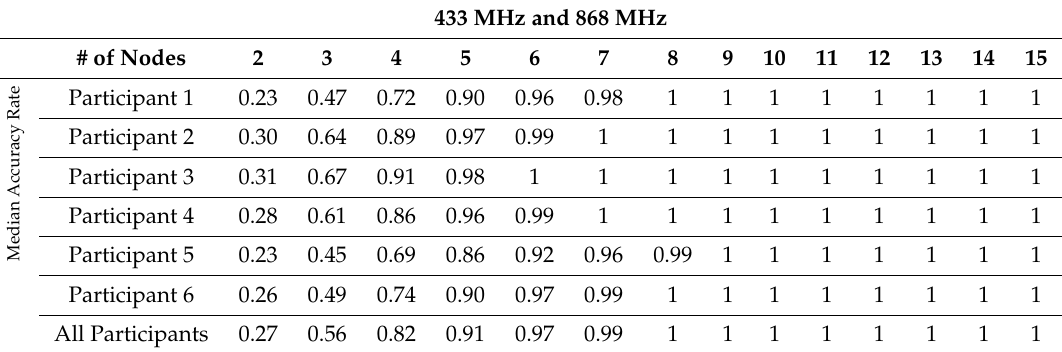
Table 5. Median accuracy rates obtained by using a naive Bayesian classifier on data from both the 433 MHz and 868 MHz network. 433 MHz and 868